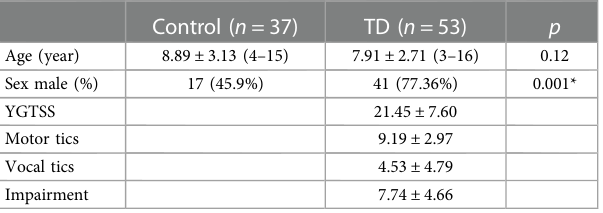
TABLE 1 General clinical data of healthy control and TD patients.